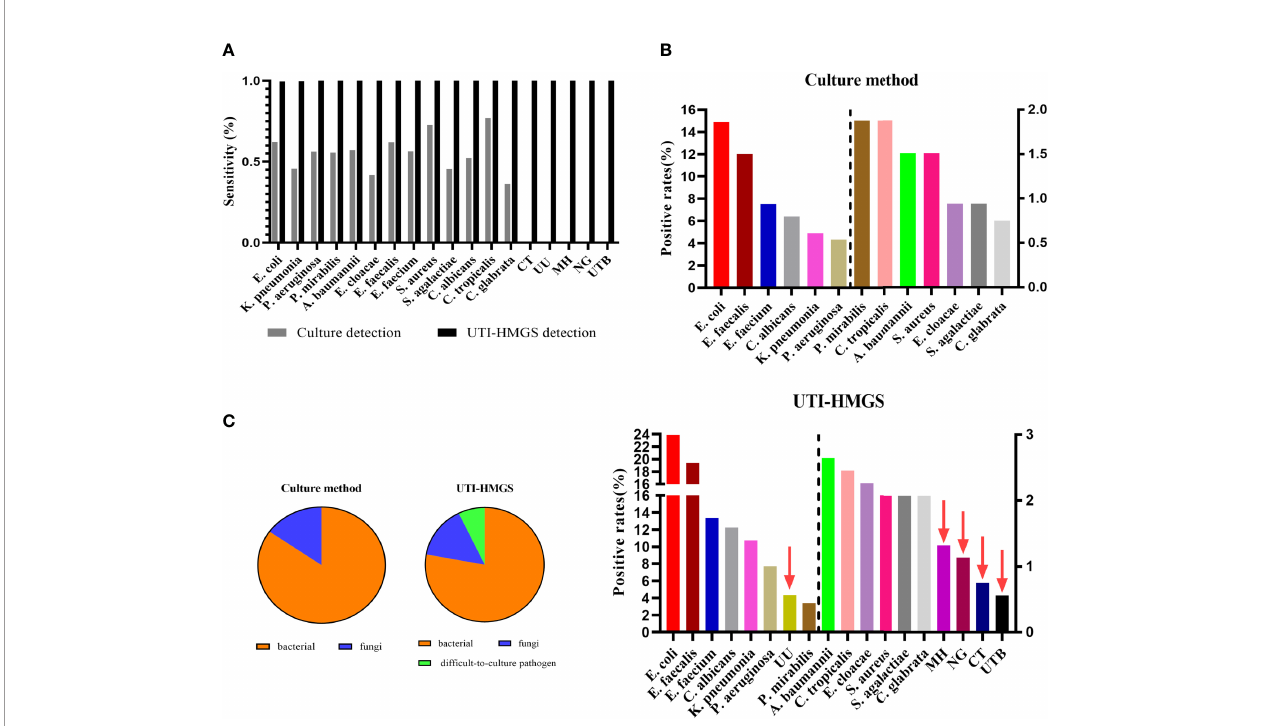
FIGURE 7 | The uniformly high sensitivity of the UTI-HMGS assay improved positive detection rates and revealed the missed detection of some important uropathogens by routine urine cultures in the clinic. (A) A comparison of the culture method versus the UTI-HMGS assay with regard to the sequencing-based detection of 18 uropathogens. The sensitivity of the UTI-HMGS assay for the detection of E. coli, K. pneumoniae ( P =0.00), P. aeruginosa ( P =0.00), P. mirabilias ( P =0.00), A. baumannii ( P =0.01), E. cloacae ( P =0.01), E. faecium ( P =0.00), E. faecalis ( P =0.00), S. agalactiae ( P =0.01), C. albicans ( P =0.00), C. glabrata ( P =0.01), CT ( P =0.04), UU ( P =0.00), MH ( P =0.01) and NG ( P =0.01) were signi fi cantly higher than that of the culture method (B) The positive detection rates of individual uropathogens ranked according to detection results from the culture method (top) and the UTI-HMGS assay (bottom). The UTI-HMGS assay improved the positive detection rates attained by the culture method and revealed the missed detection of UU, MH, CT and UTB by culture. (C) The uniform sensitivity of the UTI-HMGS assay when detecting bacteria, fungi, and dif fi cult-to-culture pathogens, altering the ratios of 13 pathogens that can be cultured versus fi ve dif fi cult-to-culture pathogens, thus underlining the importance of comprehensive detection in the diagnosis of UTIs.